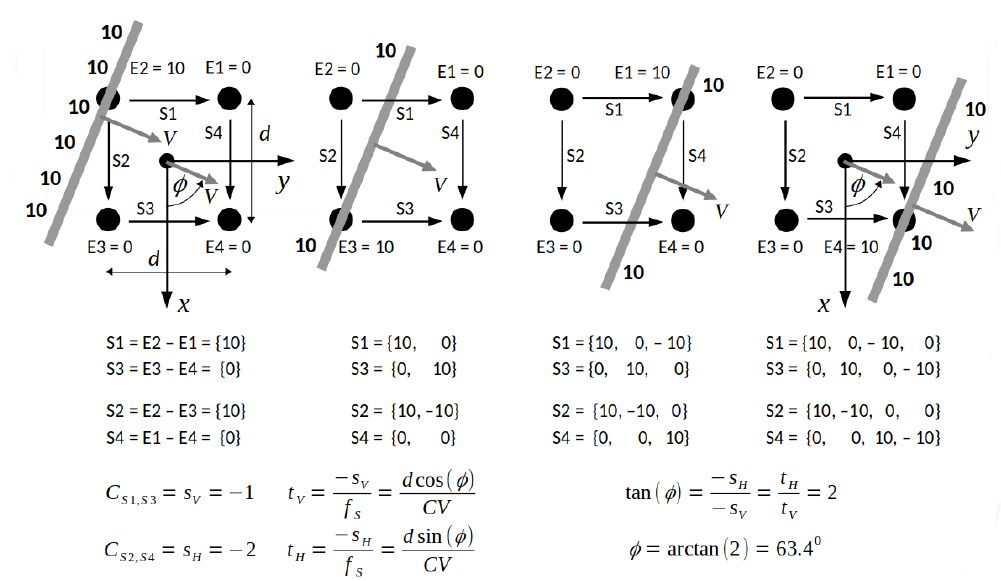
Figure A2. A detailed example of passing an EHG wave with an amplitude of, e.g., 10 µ V, over the electrodes placed on the abdominal wall, the values of the corresponding EHG signals, the cross-correlation similarity shifts, s V = C S 1, S 3 and s H = C S 2, S 4 , the transition times, t V and t H , and the calculated incidence angle φ